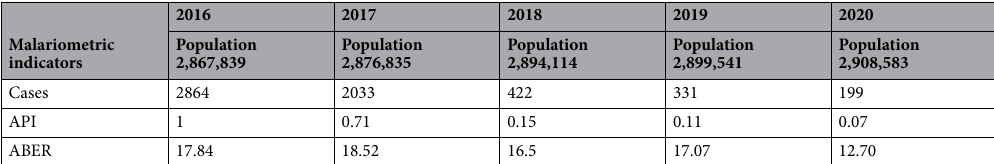
Table 2. Malariometricindices of Purulia district from 2016 to 2020. [API (Annual parasitic incidence) = Total number of positive slides for parasite in a year × 1000/Total population. ABER (Annual blood examination rate) = (Smear examination in a year × 100)/Total